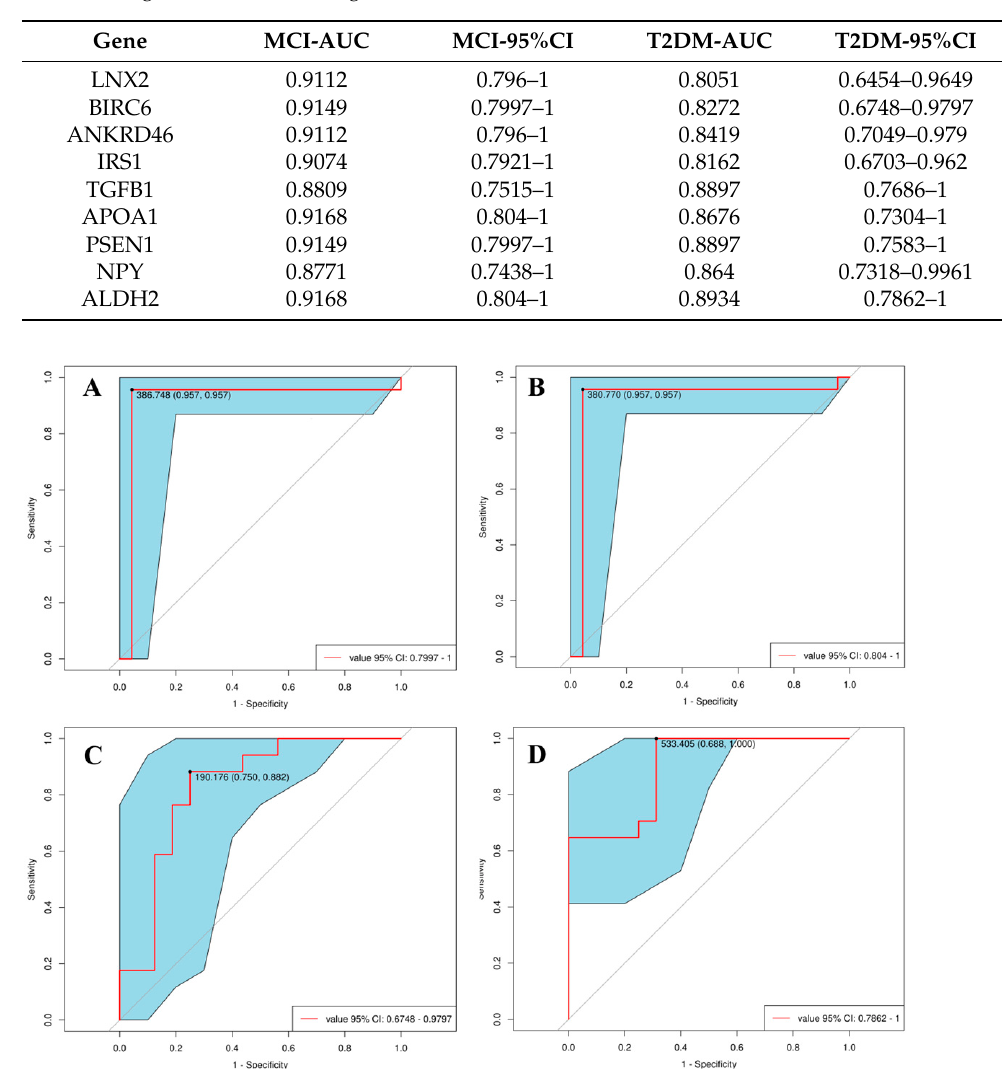
Figure 6. ROC curves of co-DEGs in MCI and T2DM. ( A ) BIRC6 in MCI; ( B ) ALDH2 in MCI; ( C ) BIRC6 in T2DM; ( D ) ALDH2 in T2DM. 3.6. Prediction of Potential Drugs and Traditional Chinese Medicine Upregulated hub genes (LNX2, BIRC6, ANKRD46, and IRS1) and downregulated hub genes (TGFB1, APOA1, PSEN1, NPY, and ALDH2) were submitted to the L1000 platform. Ranked by CMap connectivity score, the top ones indicated similar expression, and the lower ones revealed expression antagonism. These antagonistic small molecules showing antagonism could be drug candidates for treatment. The top 10 and bottom 10 compounds are listed in Table